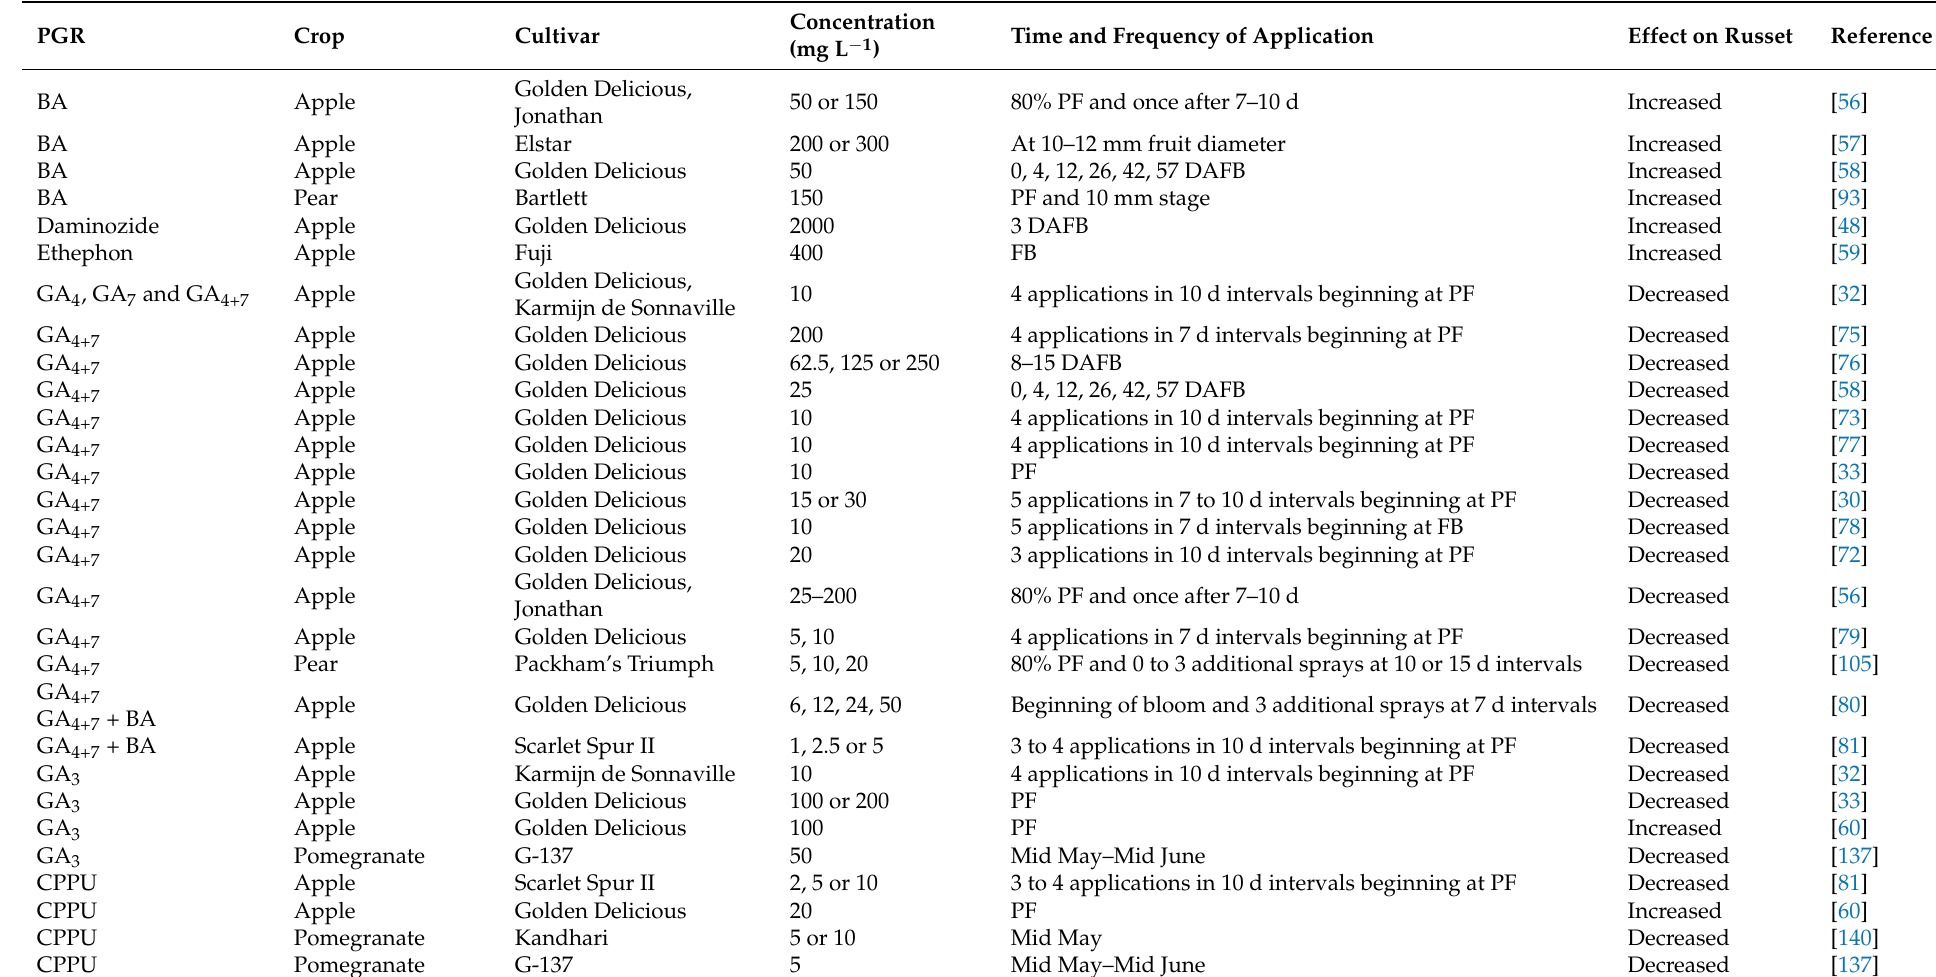
Table 4. Effect of the plant growth regulators (PGR) benzyladenine (BA), 4-(2,2-Dimethylhydrazin-1-yl)-4-oxobutanoic acid (daminozide), ethephon,